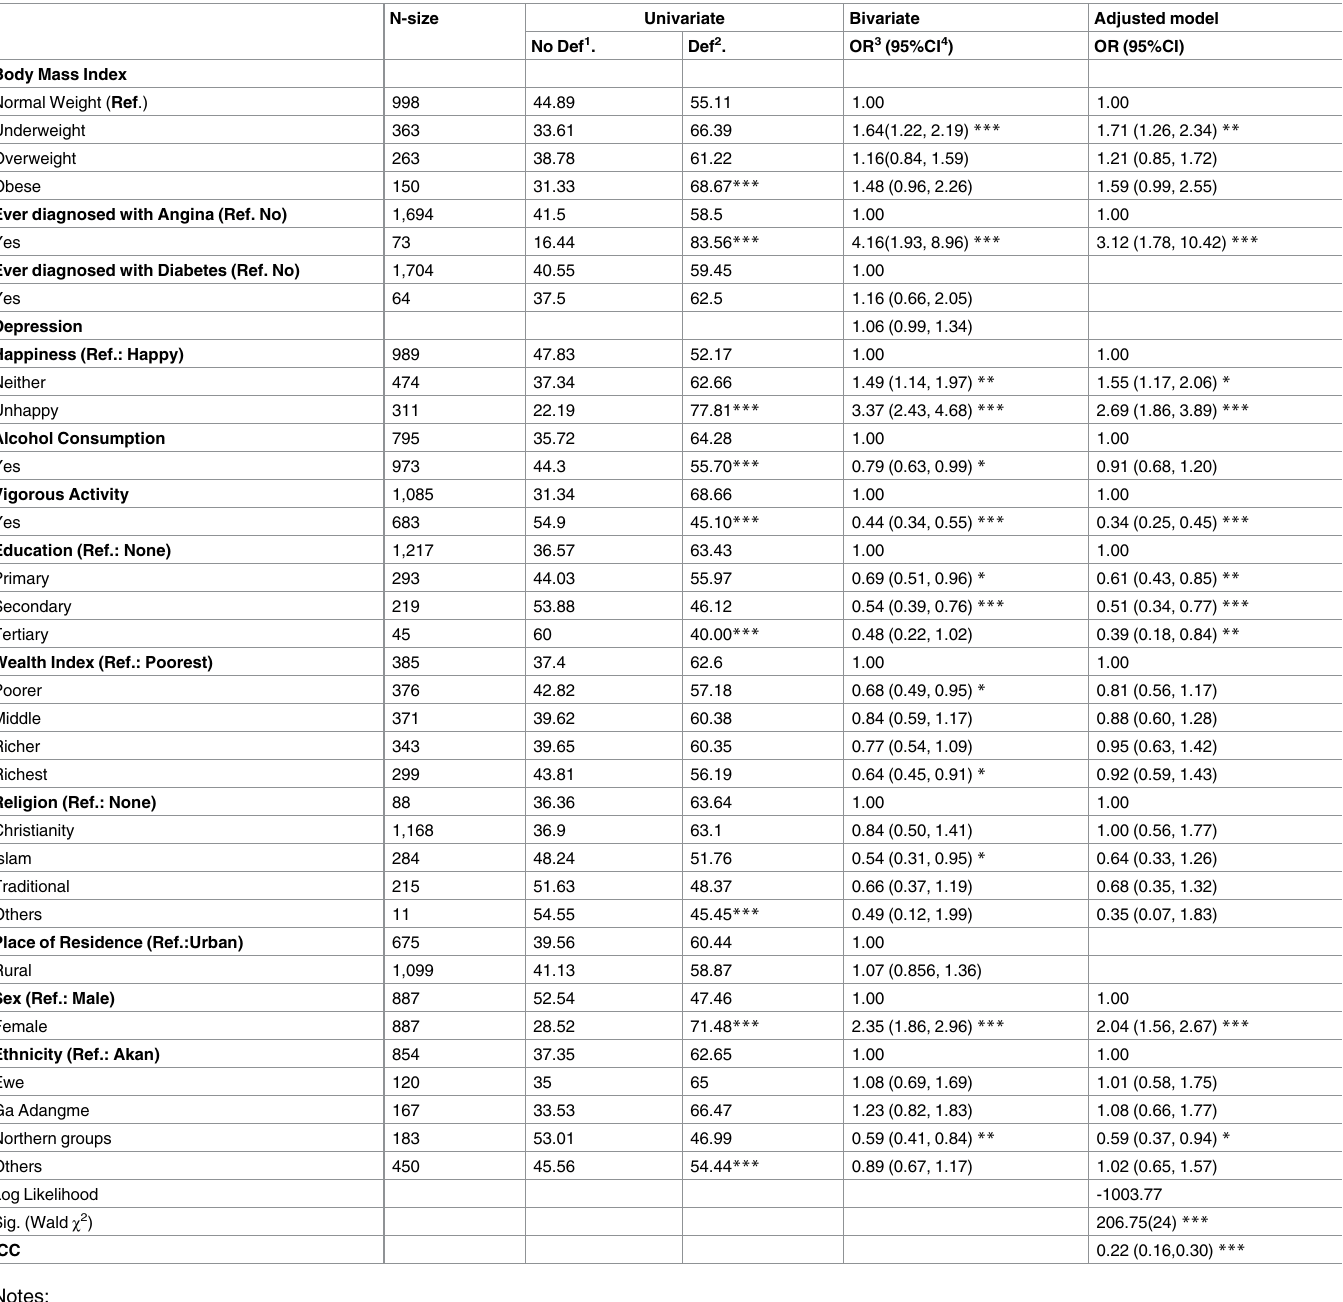
Table 6. Univariate, bivariate and adjusted results of generalized linear mixed effect logit models of activities of daily living (ADLs) on elderly obesity. N-size Univariate Bivariate Adjusted model No Def 1 . Def 2 . OR 3 (95%CI 4 ) OR (95%CI) Body